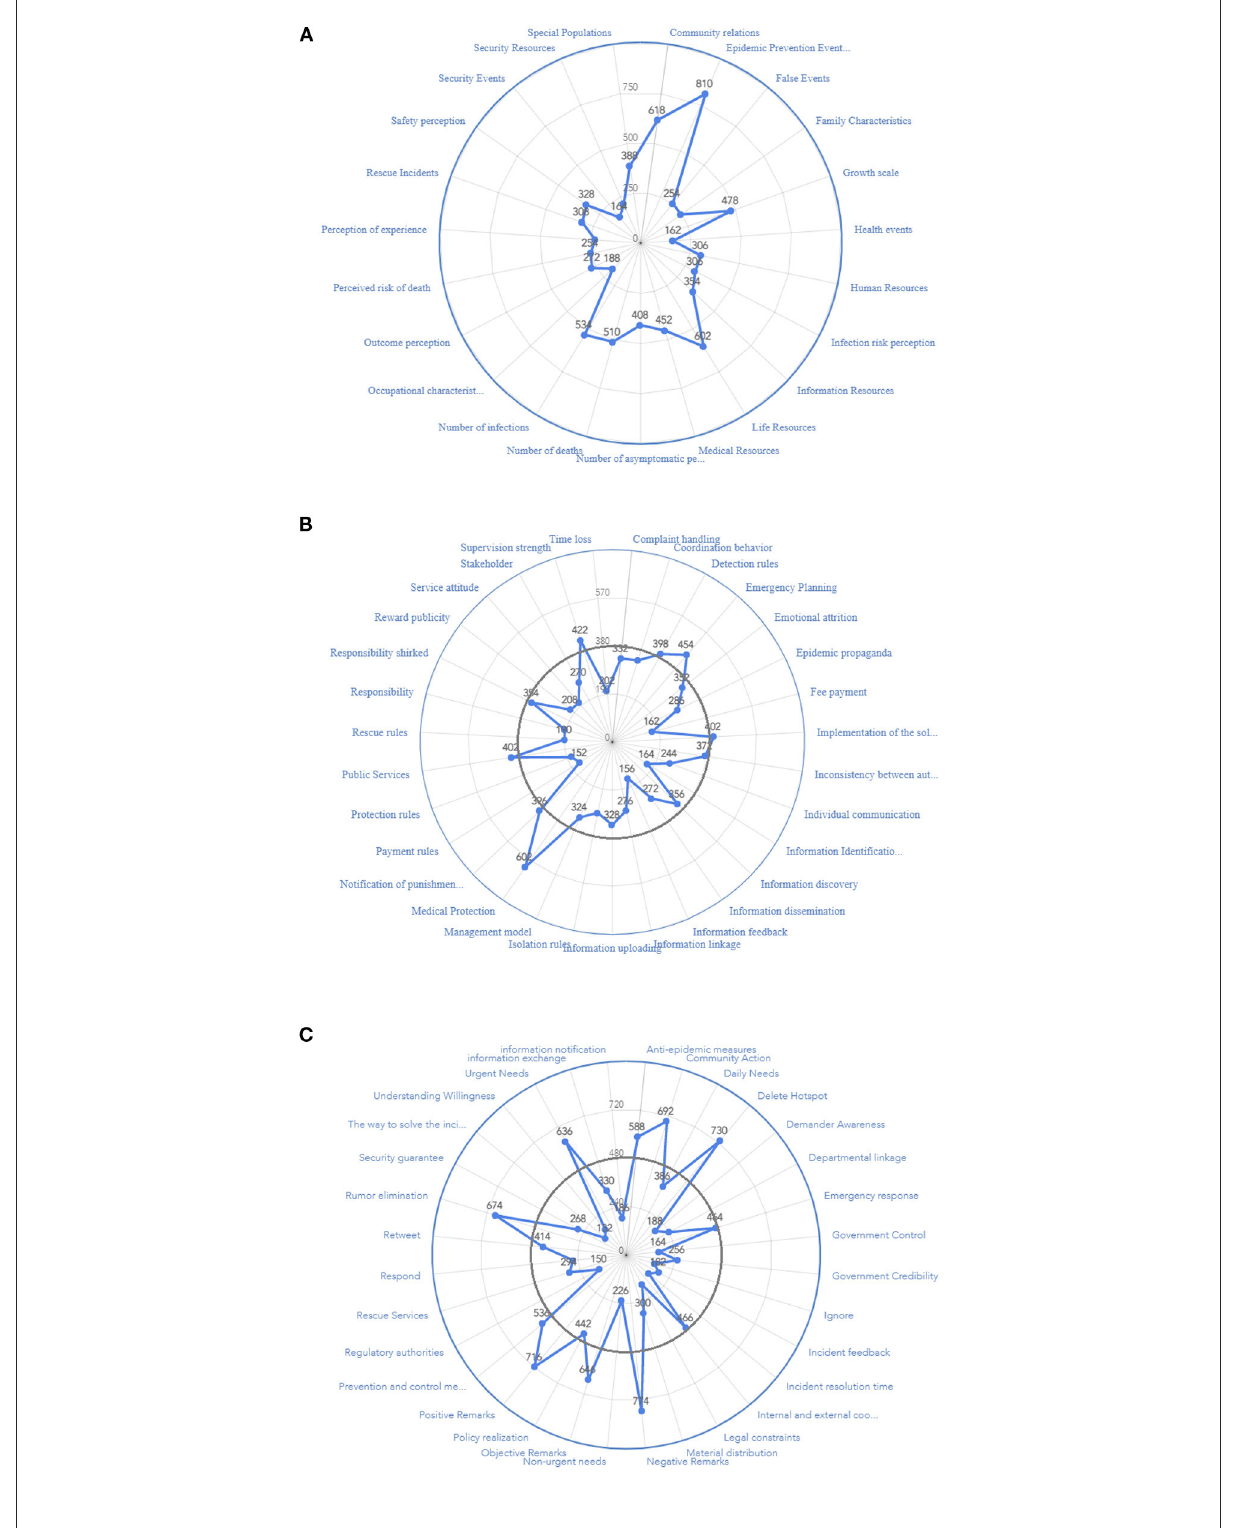
FIGURE4 Word frequency analysis. (A) Wuli, (B) Shili, and (C)